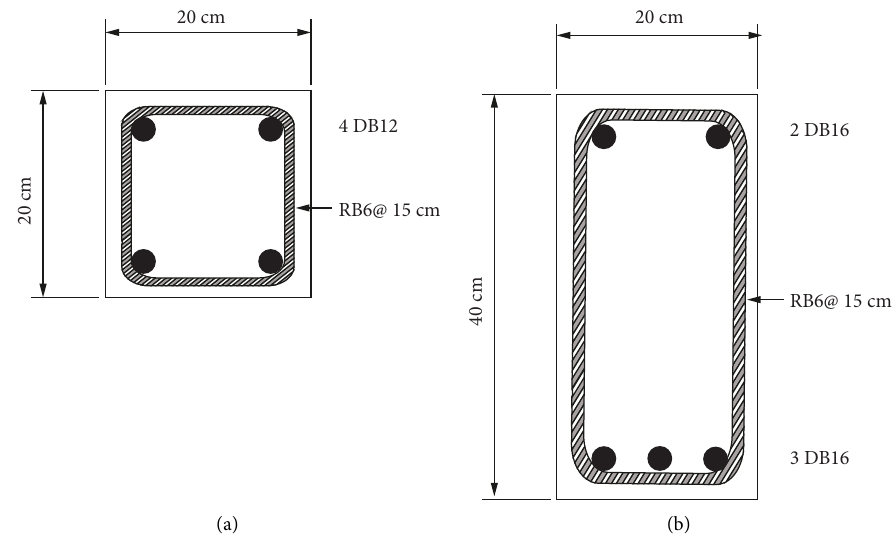
Figure 3: Te section detail of column and beam. (a) Column section. (b) Beam